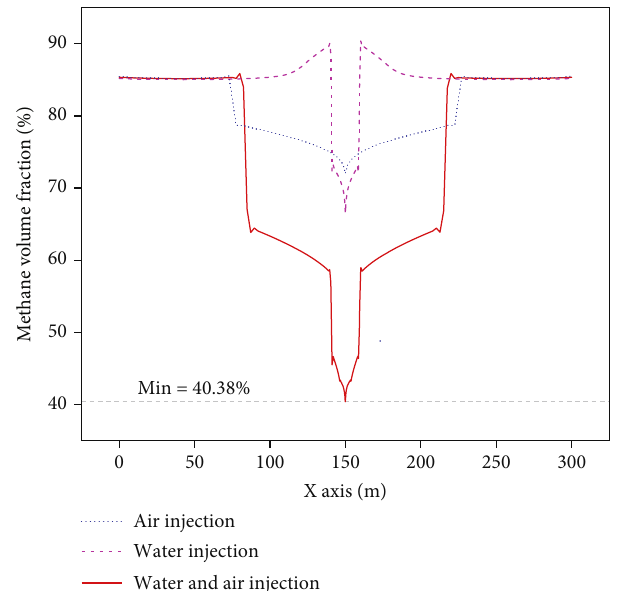
Figure 15: V under three displacement methods along line L shown in Figure CH 4